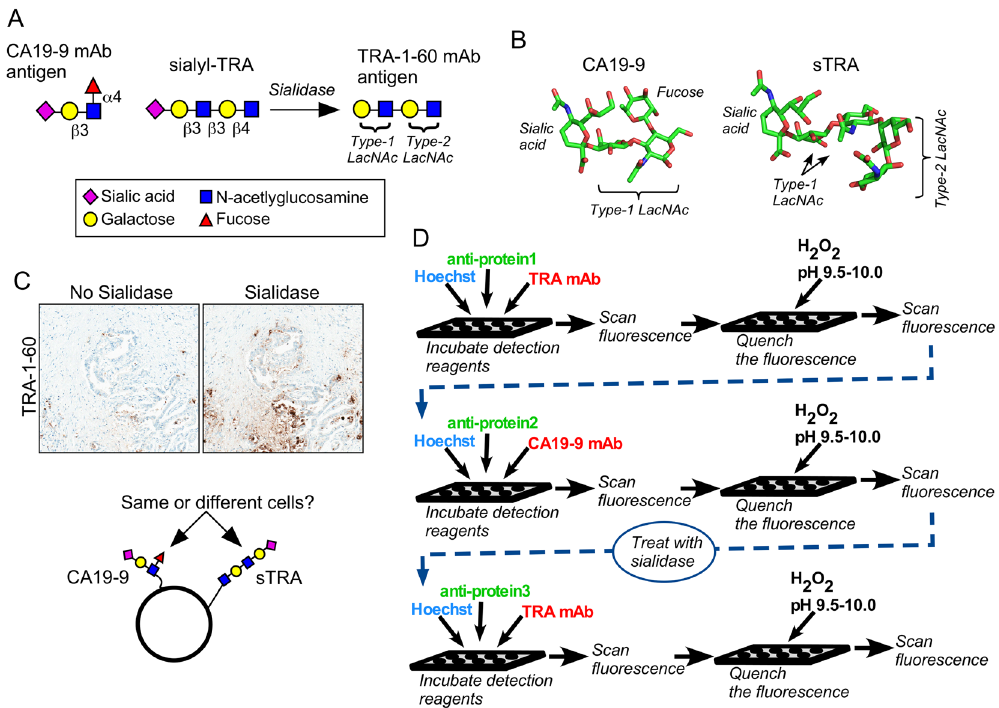
Figure 1. The CA19-9 and sialyl-TRA (sTRA) antigens. ( A ) In order to detect sTRA, we treat the sample with sialidase prior to applying the TRA-1-60 monoclonal antibody (mAb). ( B ) The CA19-9 and sTRA glycans have similar structures except for the presence of fucose in the CA19-9 antigen. ( C ) The treatment of pancreatic cancer tissue with sialidase leads to increased binding of the TRA-1-60 mAb, revealing the presence of sTRA in the tissue. The overlap with the CA19-9 antigen is not known. ( D ) The schematic shows the process we used for multimarker immunofluorescence. Between the second and third rounds, we treated the tissue with sialidase to remove sialic acid from sTRA, enabling detection by the TRA-1-60